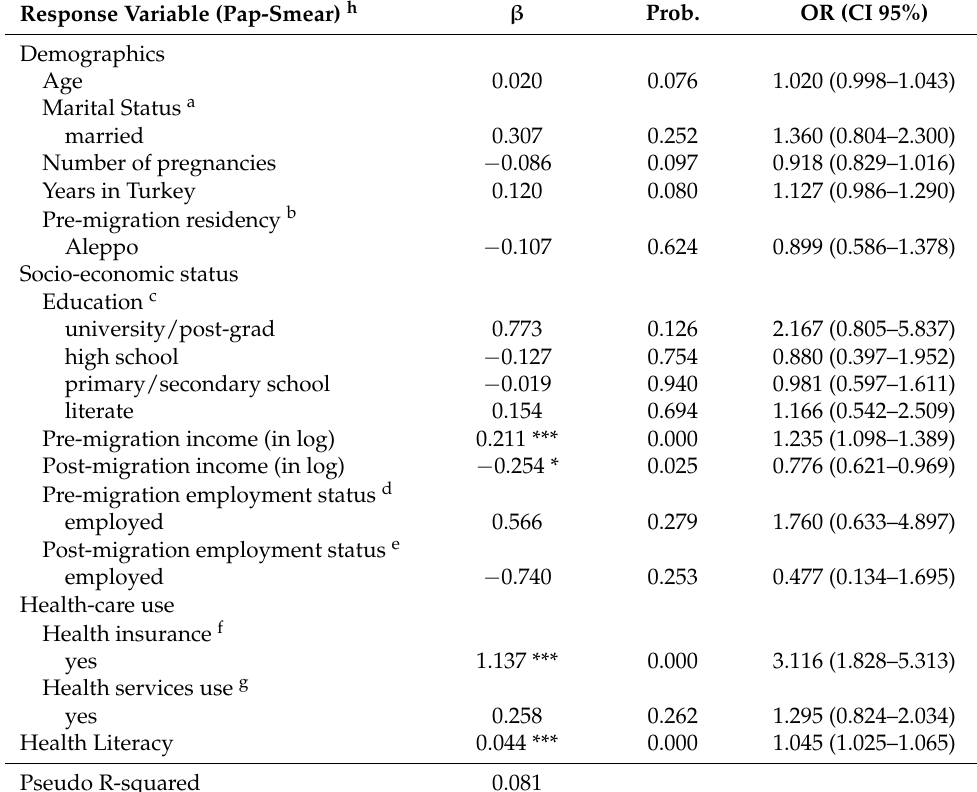
Table 2. Logistic regression estimates.